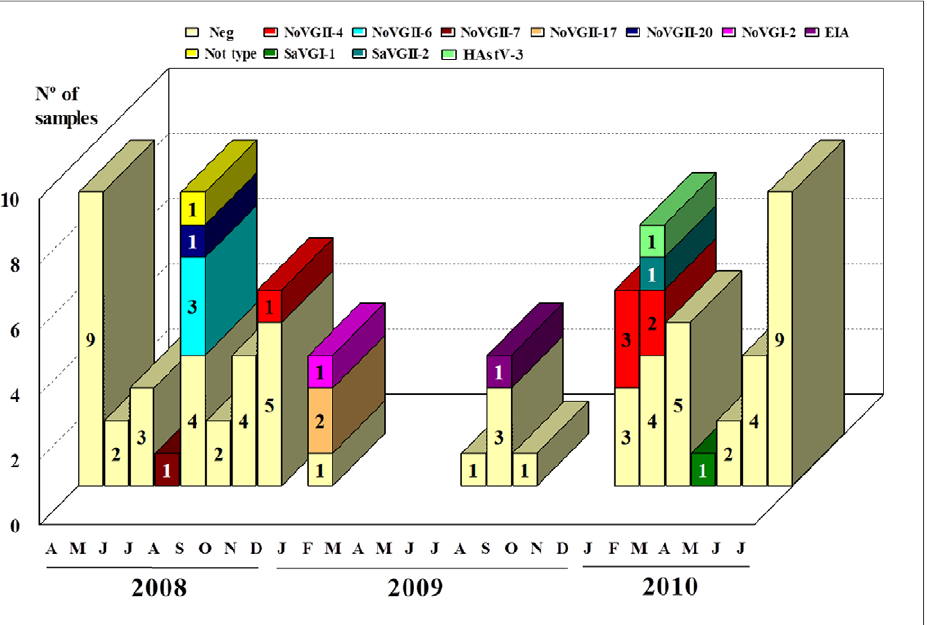
Figure 3. Monthly distribution of the positive cases of norovirus, sapovirus and astrovirus (including their genotypes) detected in stool specimens from diarrheic children of the Abacatal ‘‘Quilombola’’ Community, Para´ State, Brazil. April/2008 to